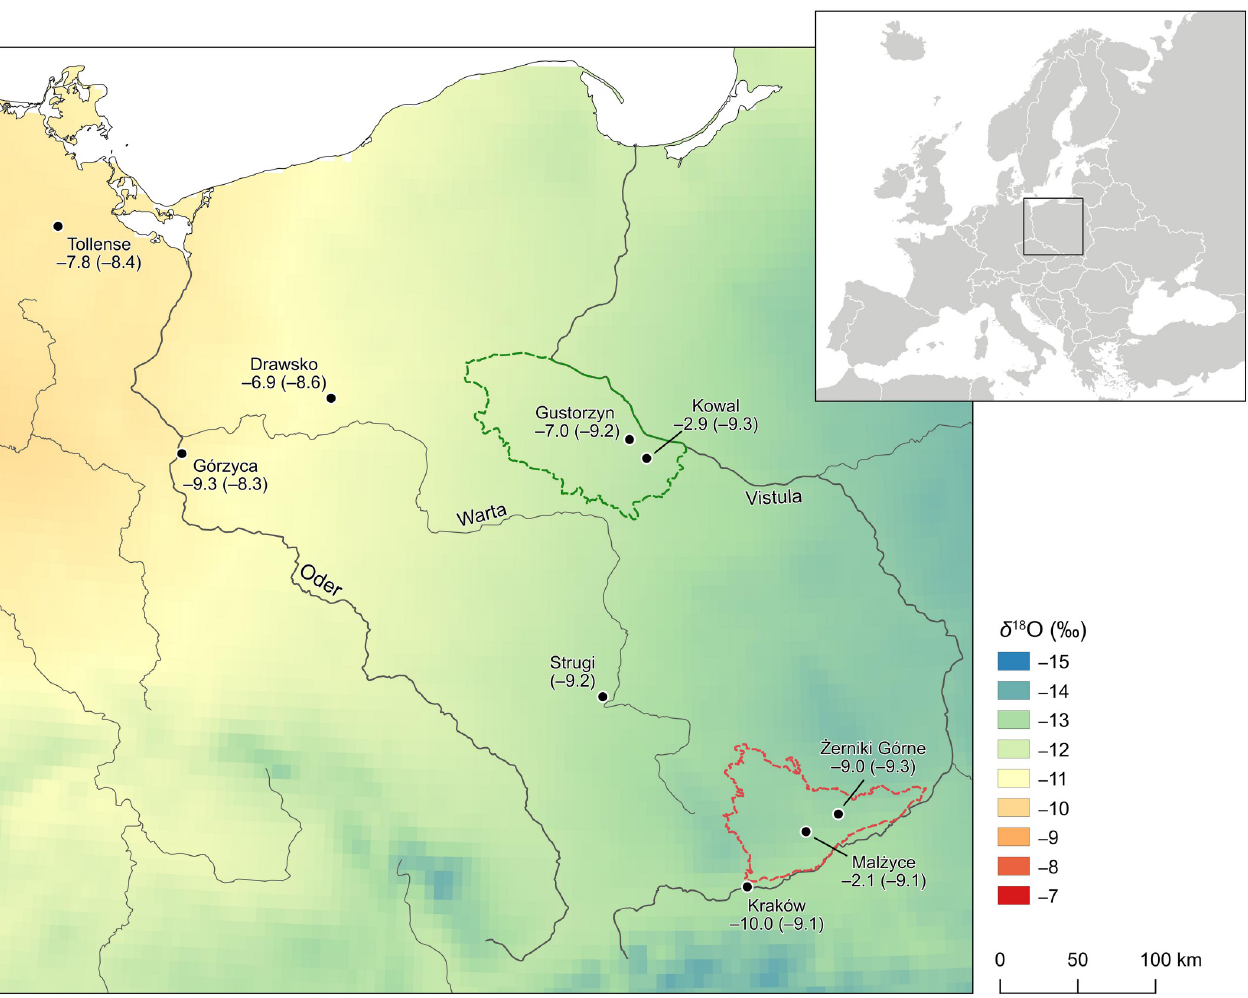
Fig 6. Map of estimated annual δ 18 O isotope ratios in precipitation in East-Central Europe. The map was produced with the QGIS 3.26.0 software, based on data from Online Isotopes in Precipitation Calculator (OIPC) database (v3.2, waterisotopes.org). Measured and/or estimated (in brackets) mean δ 18 O DW values for humans from selected sites based on data from Table 3. Inset shows location of the study area in